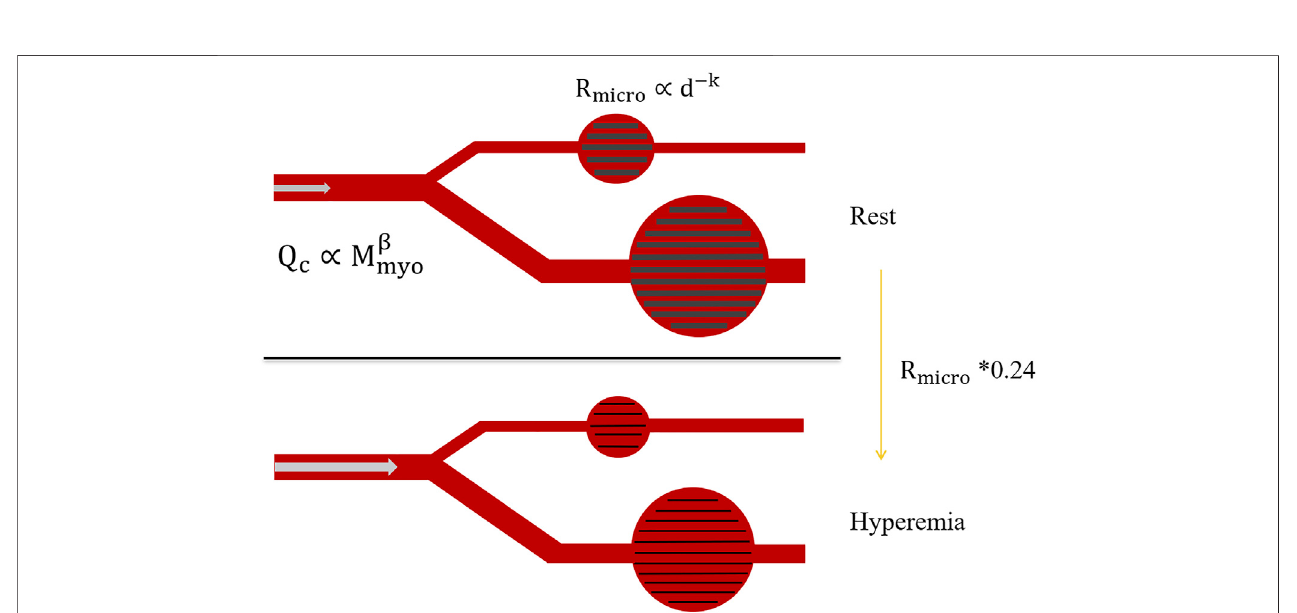
FIGURE 4 | Changes in microcirculation resistance due to